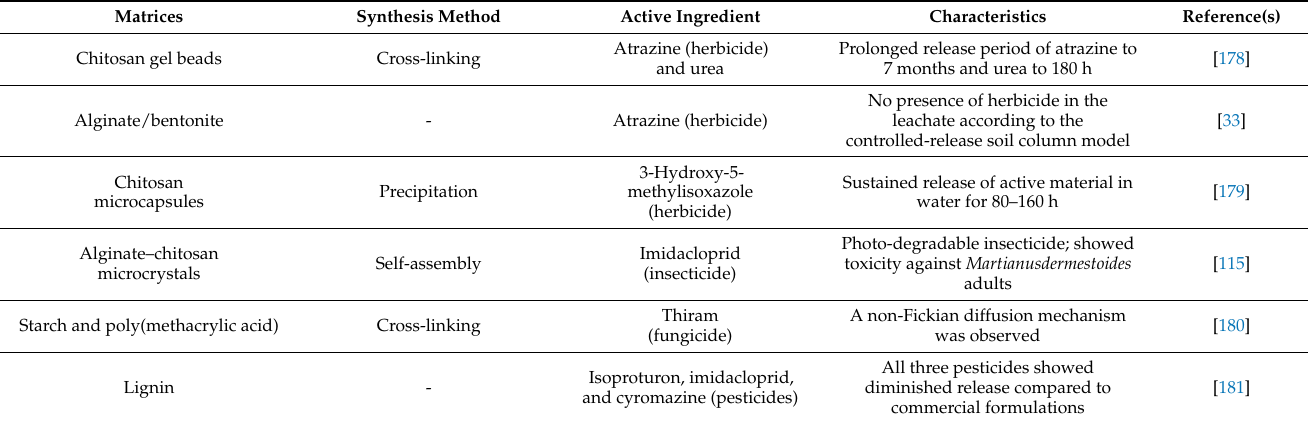
Table 9. Research on controlled-release matrices of active ingredients encapsulated in biopolymers and their use in